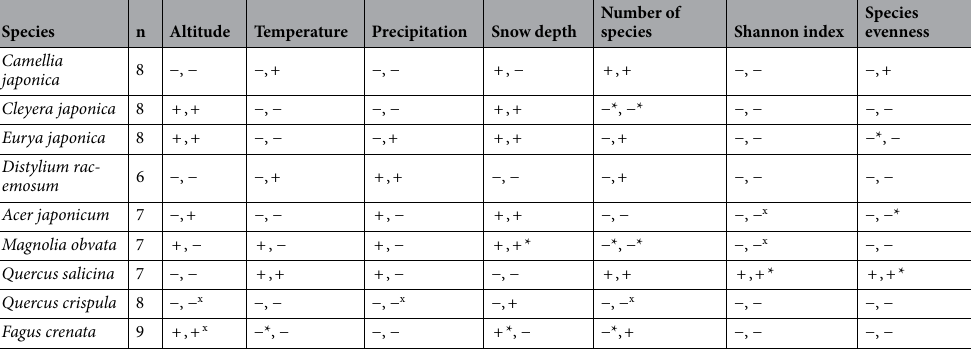
Table 1. Correlations of individual species CNDD values with environmental gradients (altitude, temperature, precipitation and snow depth) and diversity characteristics. The signs of correlations (+ for positive correlation and − for negative one) are shown for 10 m scale (before comma) and for 20 m scale (after comma). n is number of plots where species occur, * denotes significant correlations with P ≤ 0.05 and x is for P ≤ 0.1.